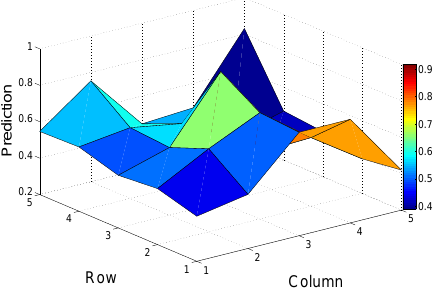
Fig. 9. The original traversability prediction of the experi- ment 1.